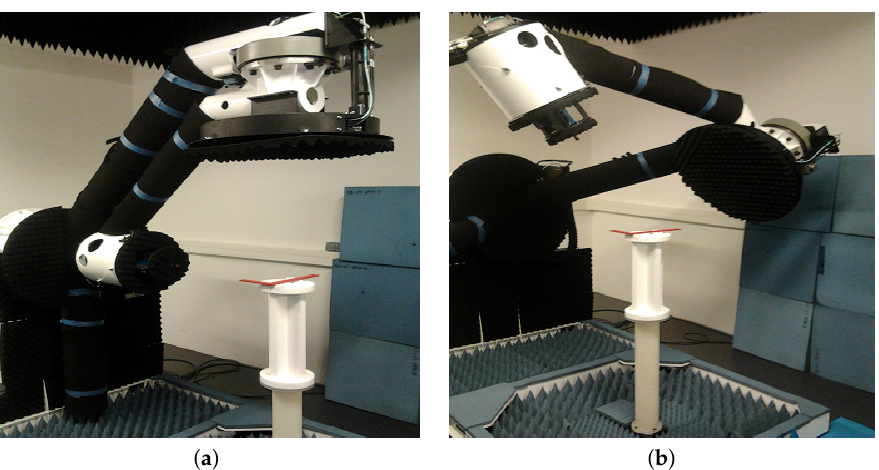
Figure 20. Photographs of the acquisition principles: ( a ) small angle, ( b ) large angle.